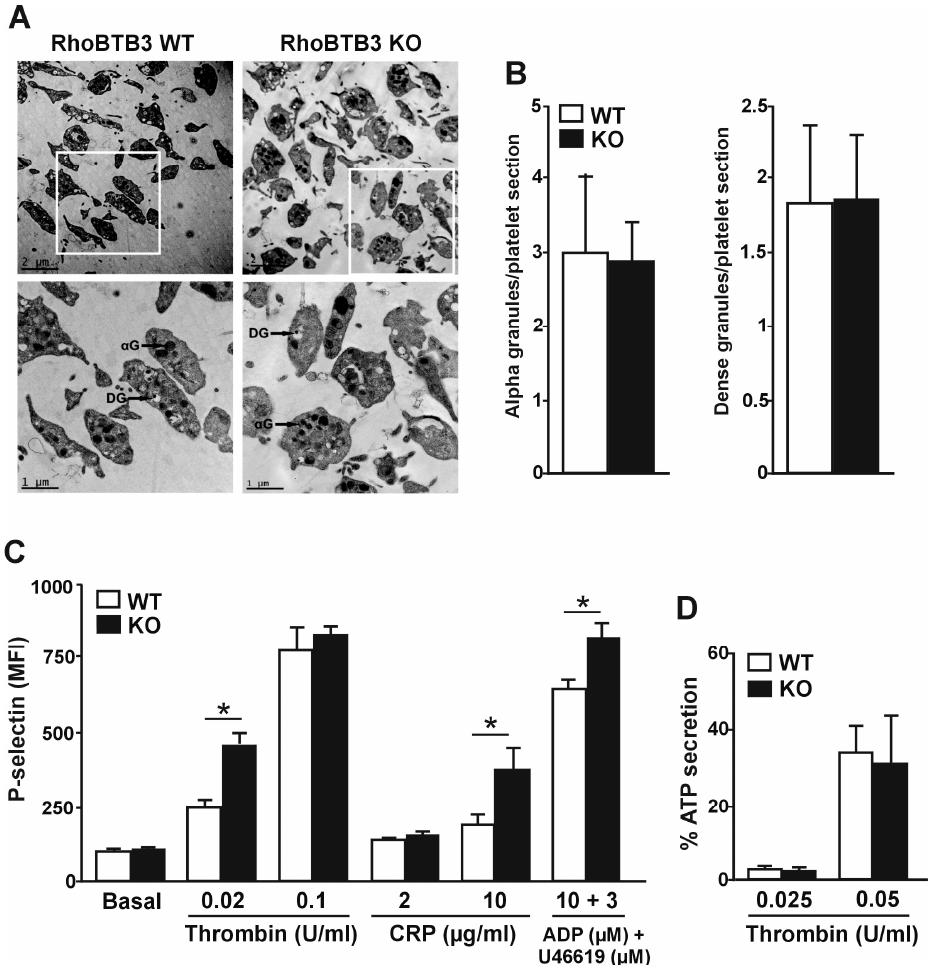
Figure 3. Ultrastructure and secretion in RhoBTB3 deficient platelets ( A ) Representative images of platelet ultrastructure of RhoBTB3 KO and WT mice. DG, dense granule; α G, alpha granule. ( B ) Quantification of the number of alpha and dense granules per platelet. Data was obtained from transmission electron micrographs. Only entire platelets were scored. Data represent average ± SD of 100–200 platelets from 3 independent preparations. ( C ) P-selectin expression (median fluorescence intensity, MFI) of either resting or stimulated platelets from 5 µ L of whole blood with the indicated doses of thrombin, CRP, or a combination of ADP and U46619. The data represent the average ± SEM of 6 independent experiments. * p < 0.05; Mann-Whitney U-test. ( D ) ATP secretion upon thrombin stimulation. Washed platelets (2.5 × 10 8 platelets/mL) were incubated at 37 ◦ C in a CHRONO-LOG lumiaggregometer in the presence of CHRONO_LUME for 2 min, followed by stimulation with the indicated doses of thrombin. Secretion traces were recorded for 5 min and used to calculate the percentage of ATP secretion. The data represent the mean ± SEM of 3 independent experiments.